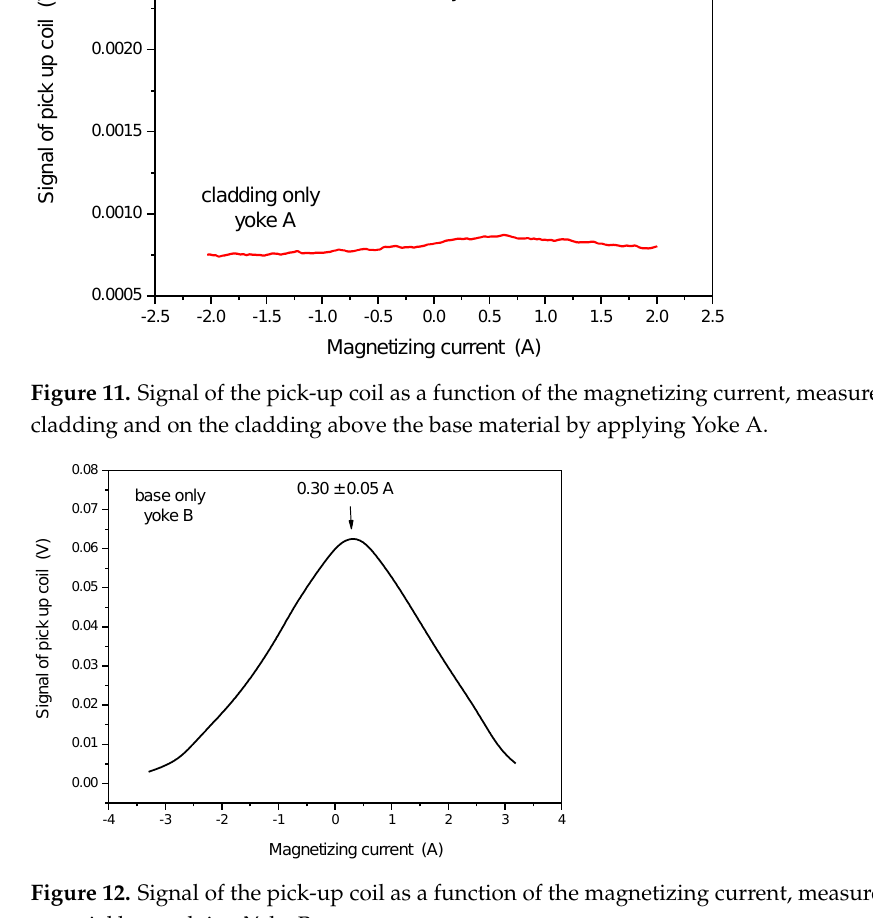
Figure 11. Signal of the pick-up coil as a function of the magnetizing current, measured on the pure cladding and on the cladding above the base material by applying Yoke A.